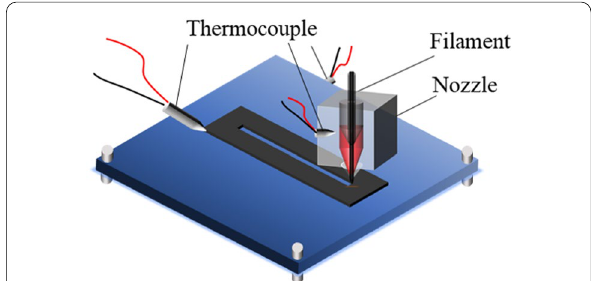
Figure 1 Sketch map of AM-FW300 continuous fiber 3D printing nozzle structure